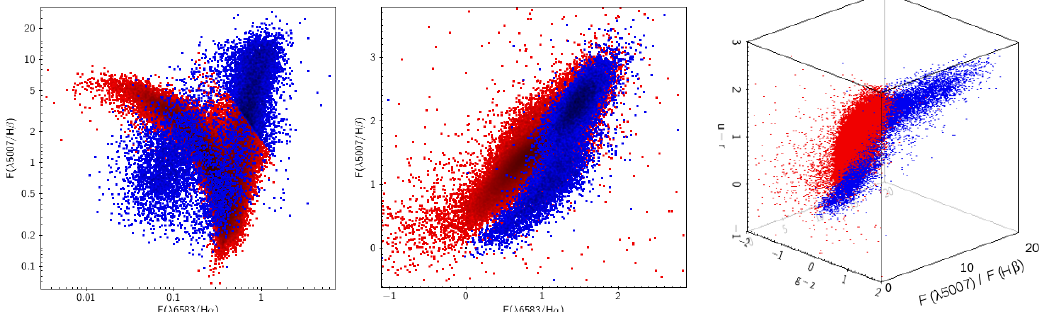
Figure 1. Distribution of active galactic nuclei (AGNs; blue points) and star formation (red points) powered objects with emission-line spectra on the [O III] λ 5007/H β vs. [N II] λ 6583/H α diagnostic diagram ( left panel ), on the u − r vs g − z color–color diagram ( middle panel ) and on the three-dimensional parameter space combining the two-color photometry with the [O III] λ 5007/H β diagnostic ratio. The distribution in the three-dimensional parameter space illustrates how Type 1 AGNs are best identified among line-emitting sources by means of photometric criteria, while Type 2 sources can be distinguished on the basis of their spectral